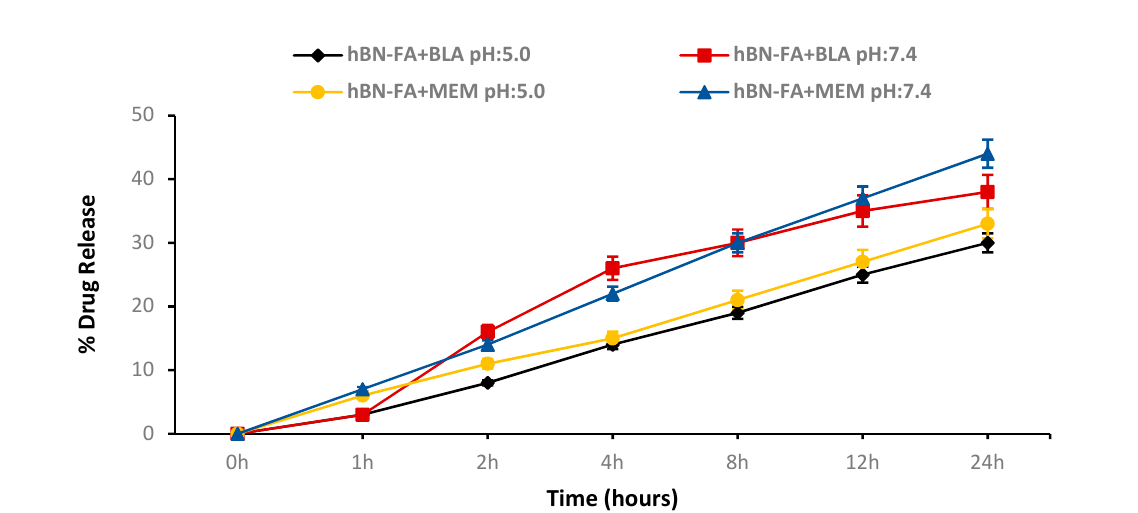
Figure 8. Drug release study for pH:5.0 and pH: 7.4.